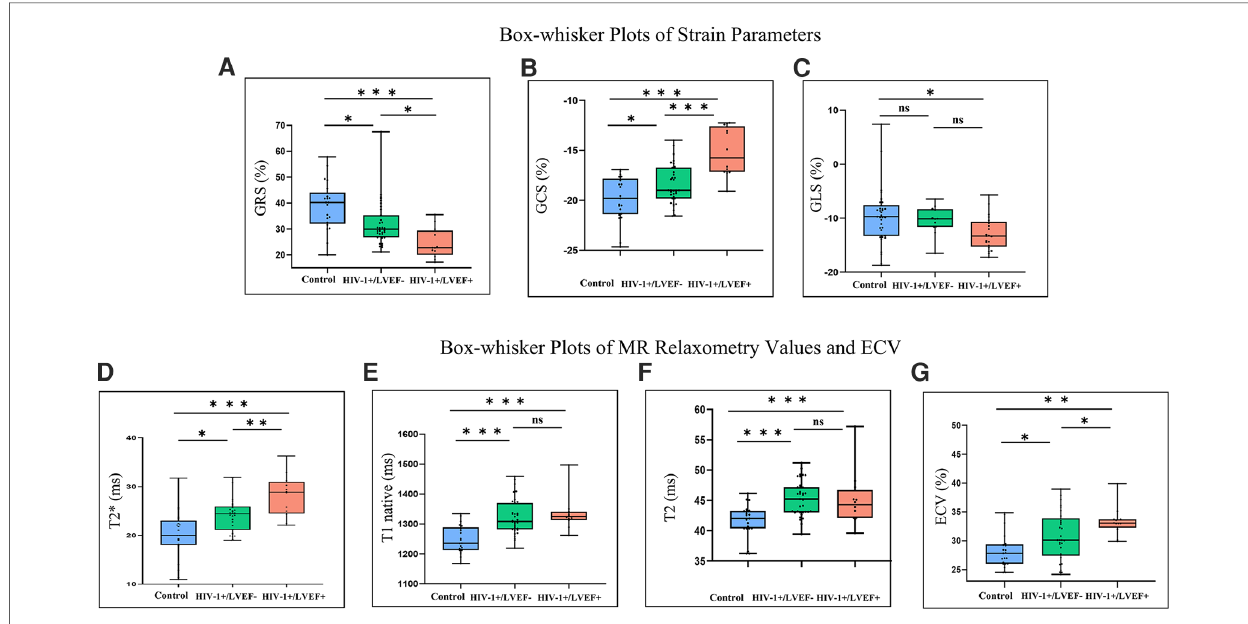
FIGURE 1 Box-whisker plots of cardiac magnetic resonance (CMR) parameters determined from control subjects and HIV-1-1infected patients with preserved LV function (HIV-1+/LVEF-) and those with LV dysfunction (HIV-1+/LVEF+). The top and bottom horizontal lines represent the maximum and minimum of the data, respectively. The colored boxes represent the data between the fi rst and third quartiles. The horizontal lines in the middle of the colored boxes represent the median. Differences are shown for GRS (A) , GCS (B) , GLS (C) , T2* values (D) , T1 native (E) , T2 (F) and ECV (G) . * Indicates signi fi cant pairwise comparison ( P <0.05), ** indicates signi fi cant pairwise comparison ( P <0.01), *** indicates signi fi cant pairwise comparison ( P <0.001). GRS, global radial strain; GCS, global radial strain; GLS, global longitudinal strain; ECV, extracellular volume; LGE, late gadolinium